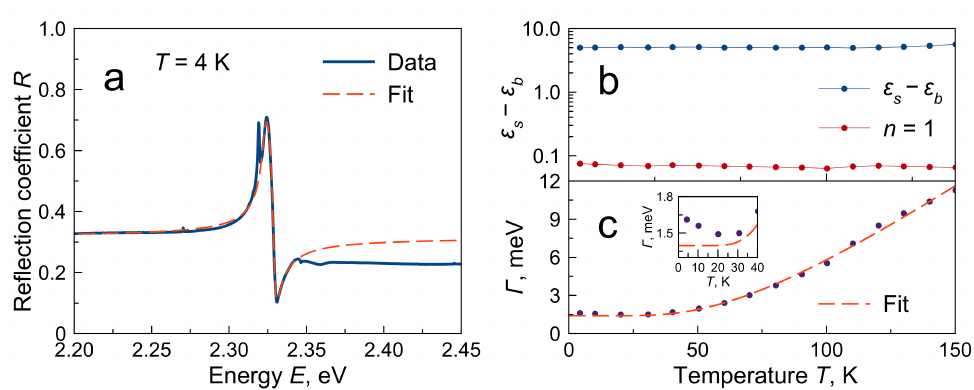
Figure 3. ( a ) Reflectivity spectrum in normal geometry for T = 4 K and a fit by Equation (3). ( b ) Temperature dependence of the dielectric constant jump calculated as the ε s − ε b difference (blue curve) and for the n = 1 resonance as f 1 (red curve). ( c ) Temperature dependence of the broadening E 2 1 of the excitonic resonance extracted from fit. Dashed curve—fit by Equation